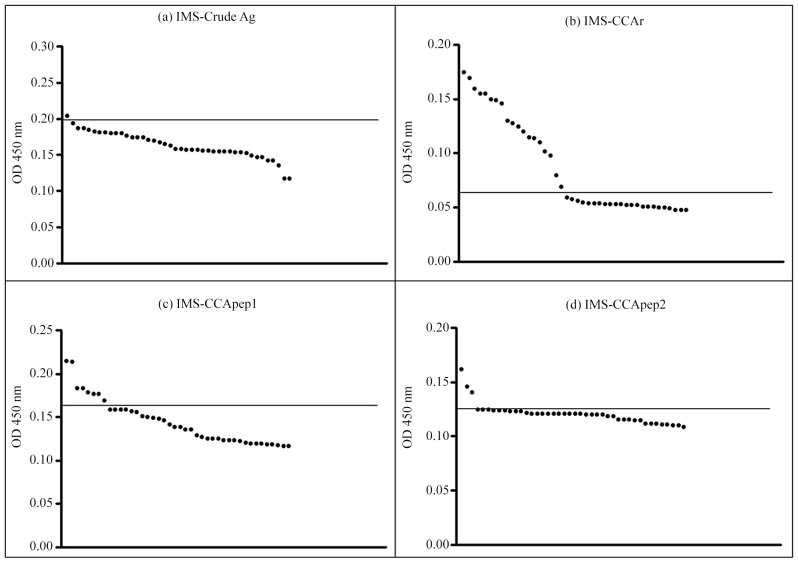
Individual analysis of IgG titer in 30 days after praziquantel administration by IMS protocols.Each OD value is representative for the mean of four absorbance values. Cut-off values are represented by bars. In: (a) IMS-crude Ag; (b) IMS-CCAr; (c) IMS-CCApep1; and (d) IMS-CCApep2. Artwork created by Prism 5.0 software.